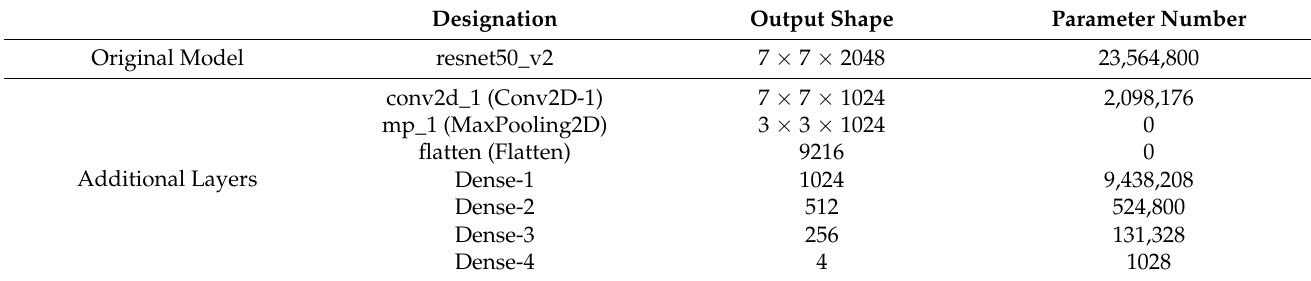
Table 7. The proposed modified-based ResNet50 V2 model